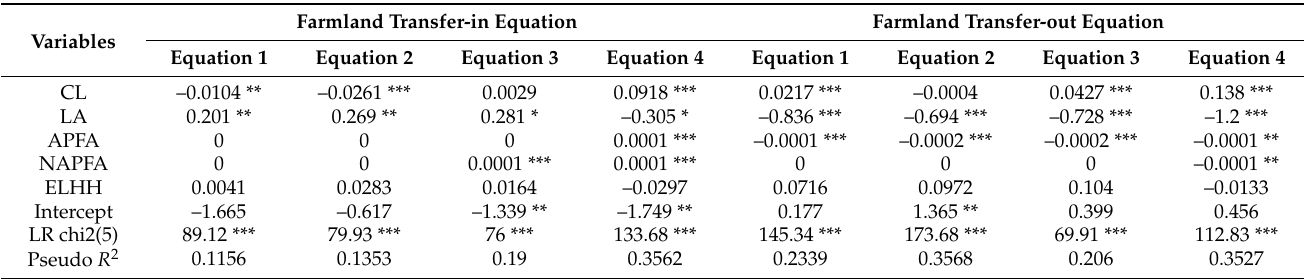
Table 2. Estimation results of decision-marking of equations of farmland transfer.